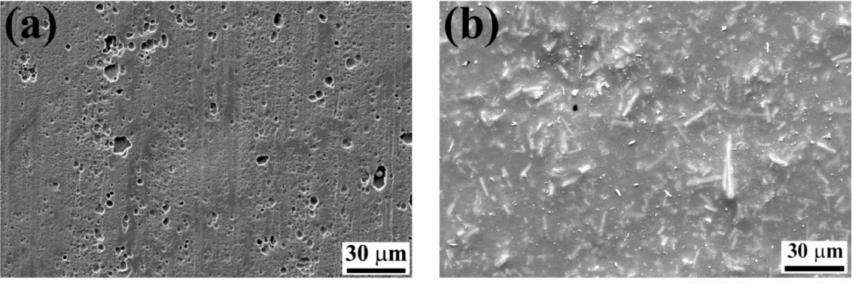
Figure 5. SEM images of the aluminum side of the joint after 28 days of aging; ( a ) PAA and ( b ) PAA-P